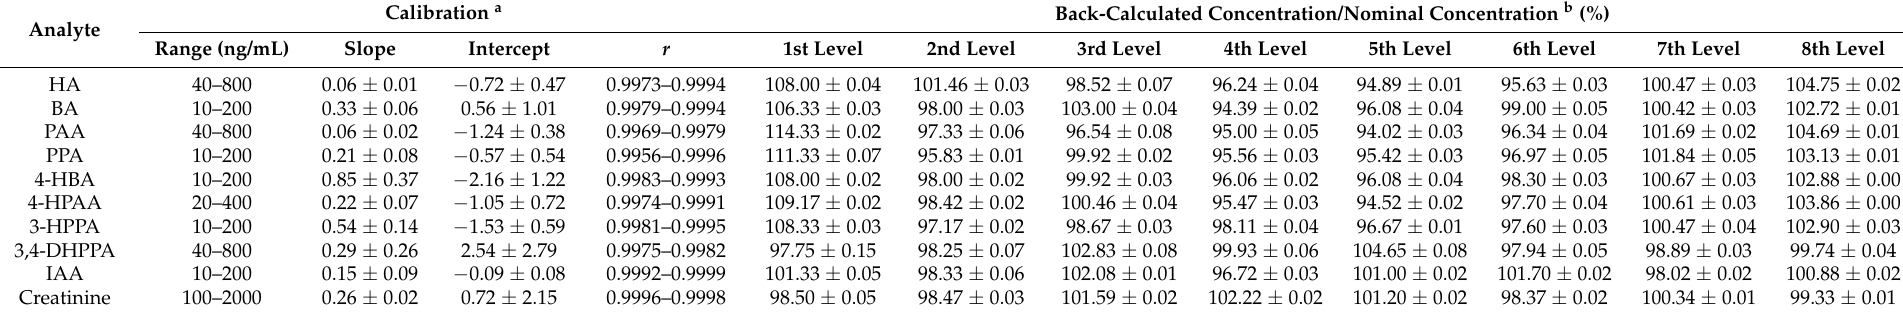
a Three calibration curves ( n = 3) were used for calculation of slope, intercept, r , and accuracy of each level. b The nominal concentrations of level 1–8 were 10, 20, 40, 60, 80, 100, 150, and 200 ng/mL for BA, PPA, 4-HBA, 3-HPPA, and IAA; 20, 40, 80, 120, 160, 200, 300, and 400 ng/mL for 4-HPAA; 40, 80, 160, 240, 320, 400, 600, and 800 ng/mL for HA, PAA, and